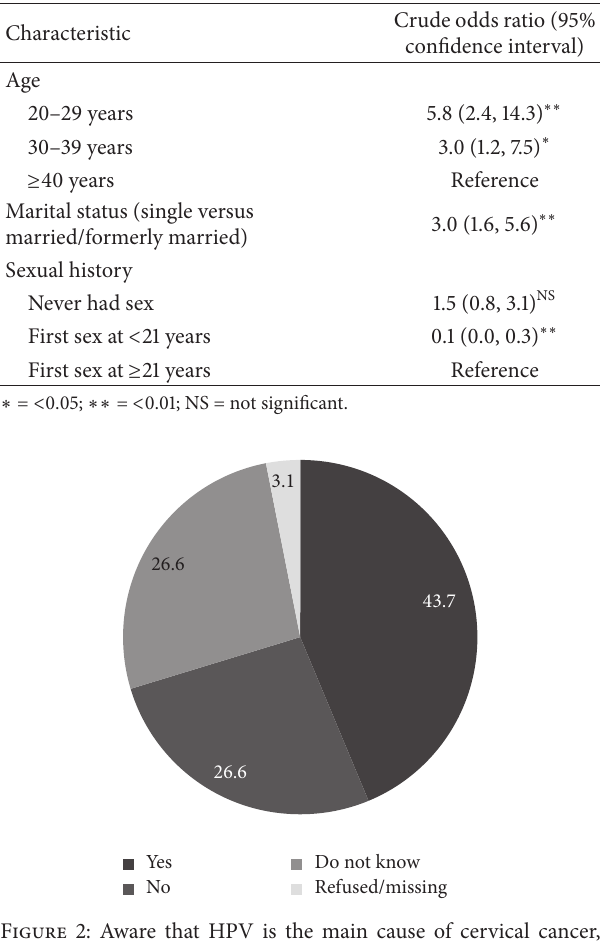
Figure 2: Aware that HPV is the main cause of cervical cancer, among those have heard of HPV, Odisha, India ( 𝑛 = 64 ).